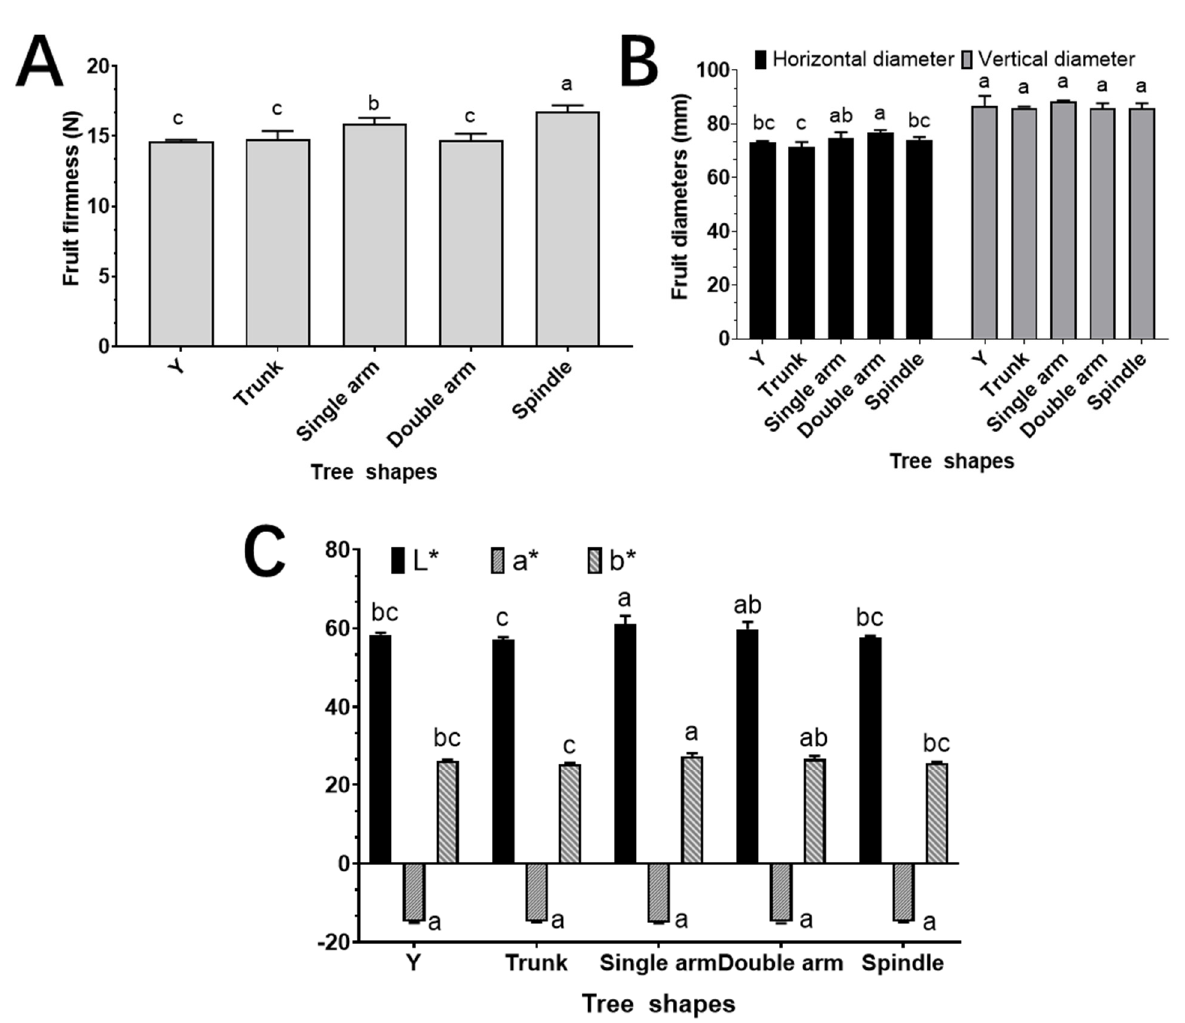
Figure 5. The effects of different tree shapes on fruit firmness ( A ), fruit diameter ( B ), and fruit peel colour ( C ). The error bars represent the standard deviation (SD), and the lowercase letters indicate statistically significant ( p < 0.05) differences between tree shapes.